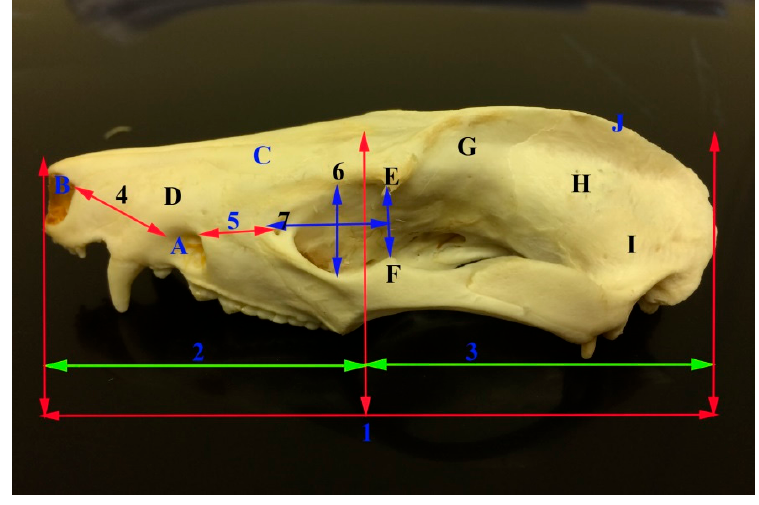
Figure 2. Photograph of the lateral view of the skull of the common opossum showing the skull measures. A infraorbital foramen; B a notch between the nasal and incisive bones; C nasal bone; D incisive bone; E zygomatic process of frontal bone; F frontal process of zygomatic bone; G frontal bone H Parietal bone; I temporal bone; J external sagittal crest; 1 skull length; 2 nasal length; 3 cranial length; 4 distance between the notch between the infraorbital foramen as well as nasal and incisive bones; 5 distance between infraorbital foramen and medial canthus of the eye; 6 orbital length; and, 7 orbital width.